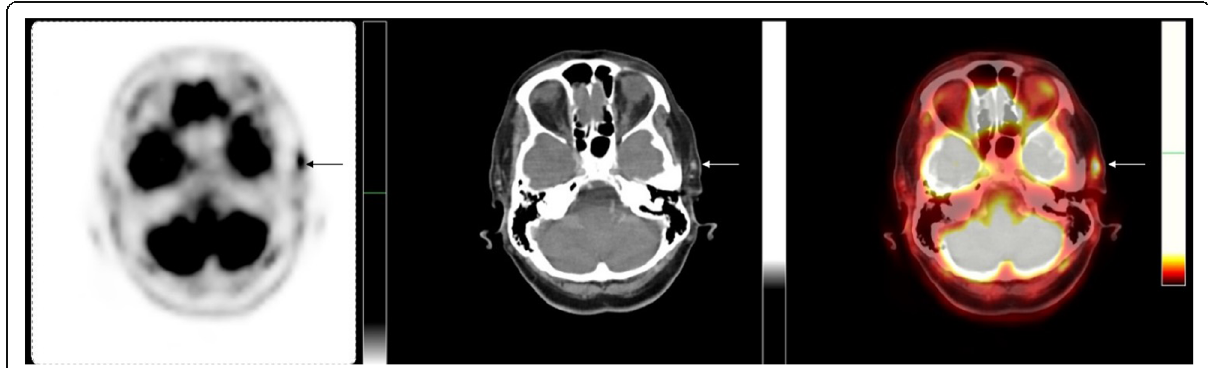
Fig. 2 Increased FDG uptake in the temporal arteries, more pronounced on the left. Images from left to right: FDG-PET, CT (soft window), and fusion